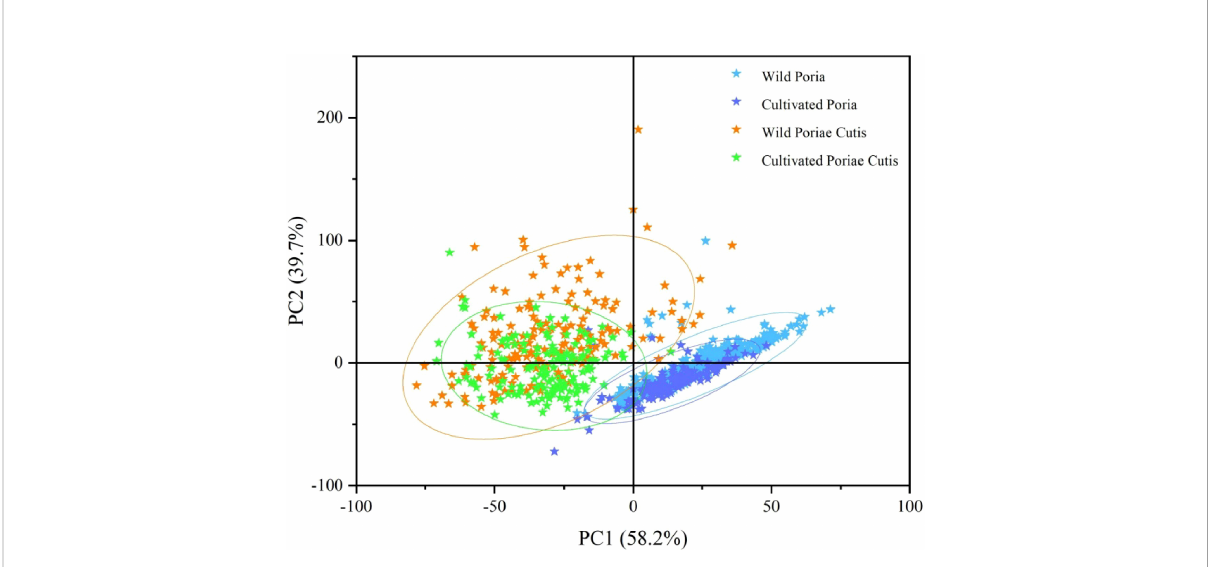
FIGURE 2 PCA score plot based on FT-NIR